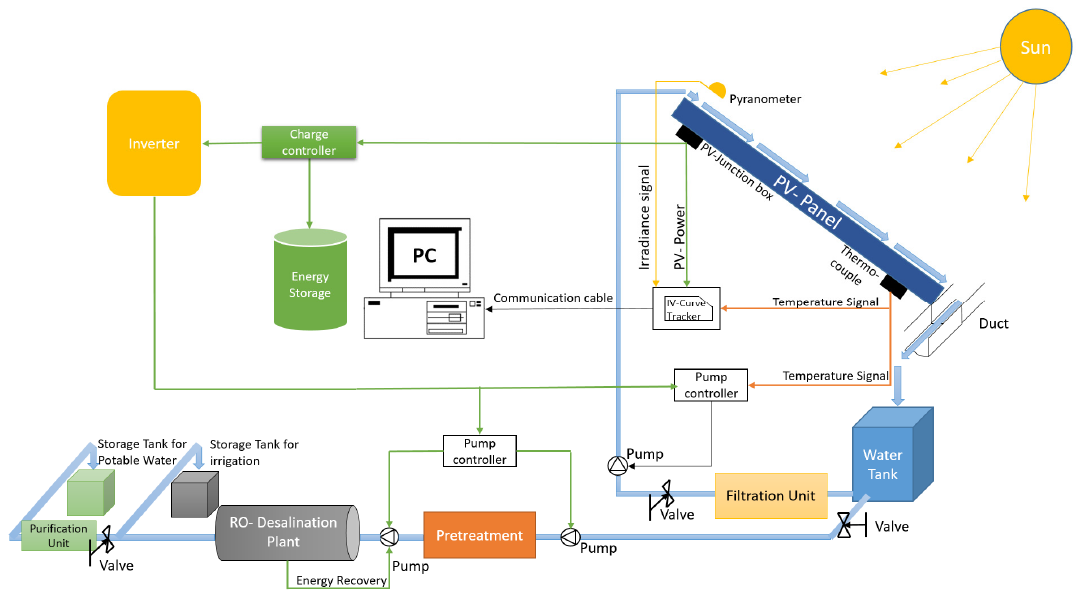
Figure 4. Schematic diagram of the proposed system.